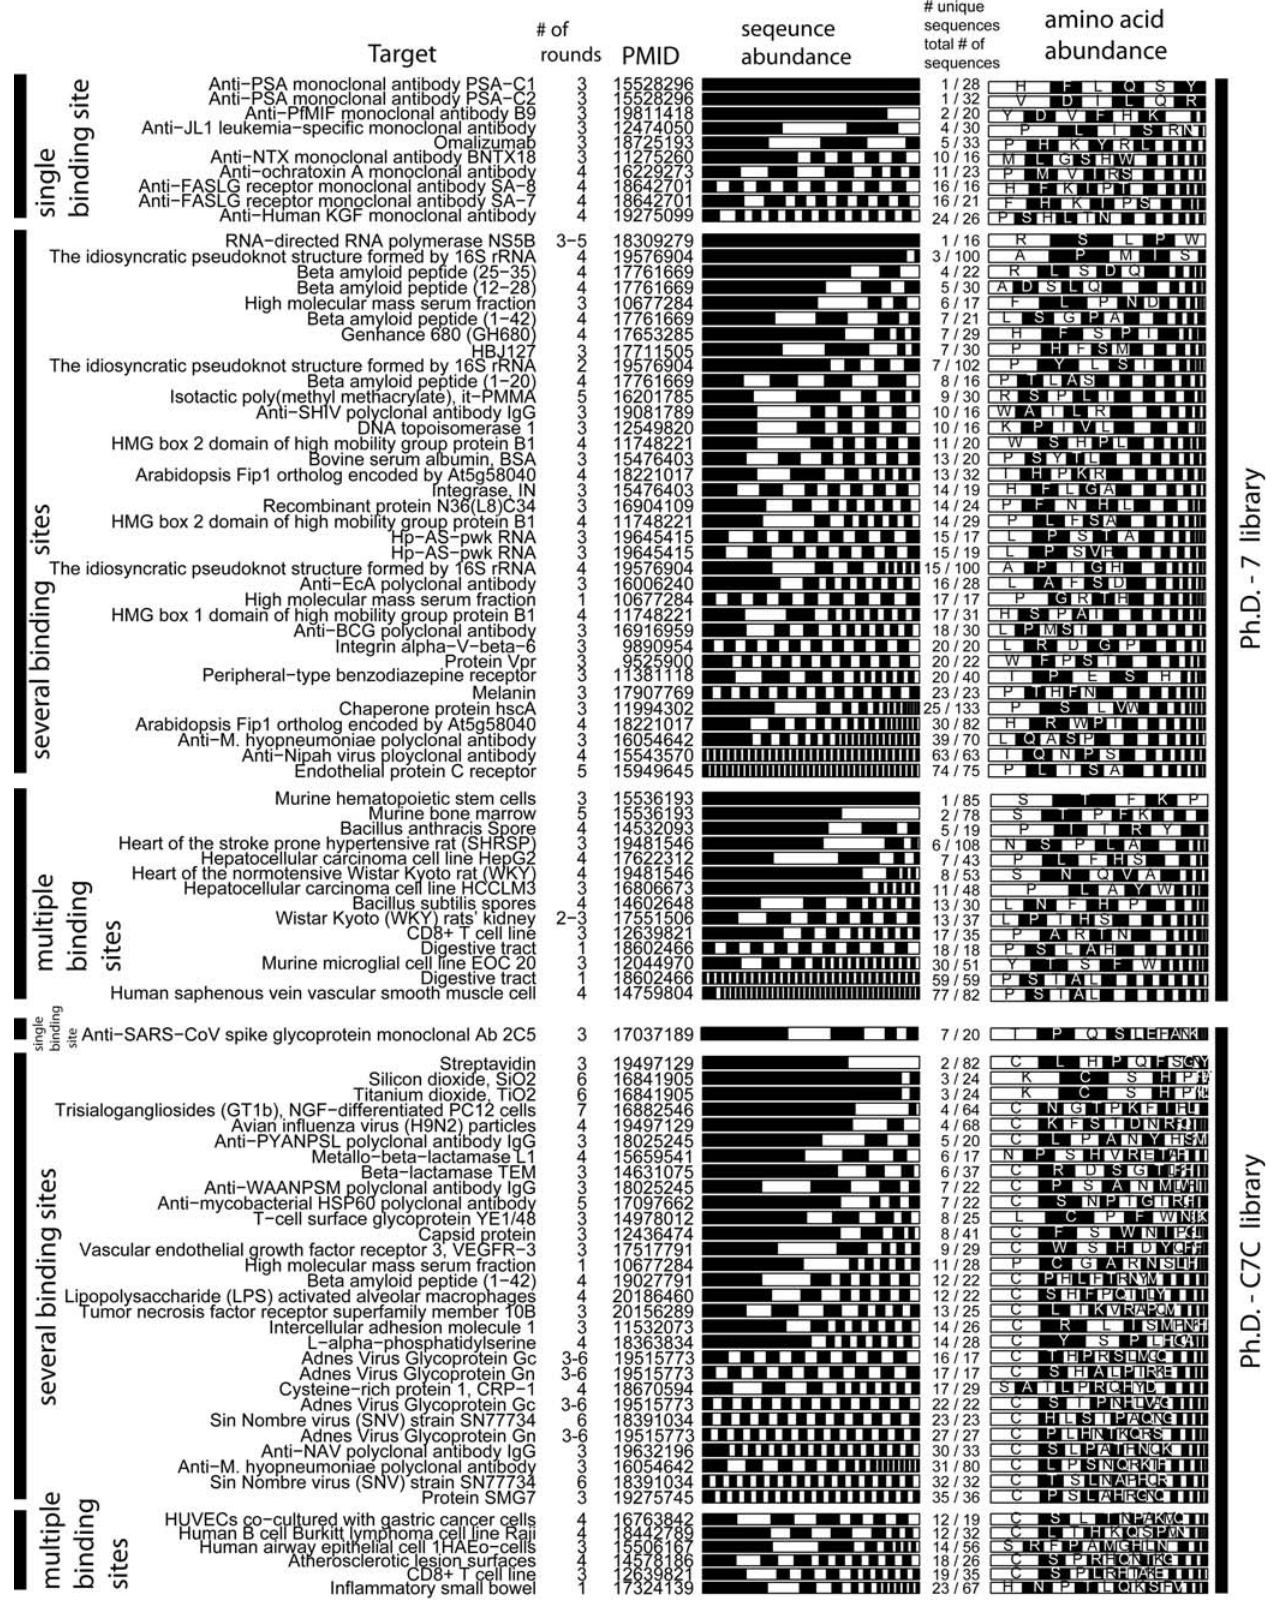
Figure 4. Analysis similar to Figure 3, but for Ph.D.-7 and Ph.D.-C7C